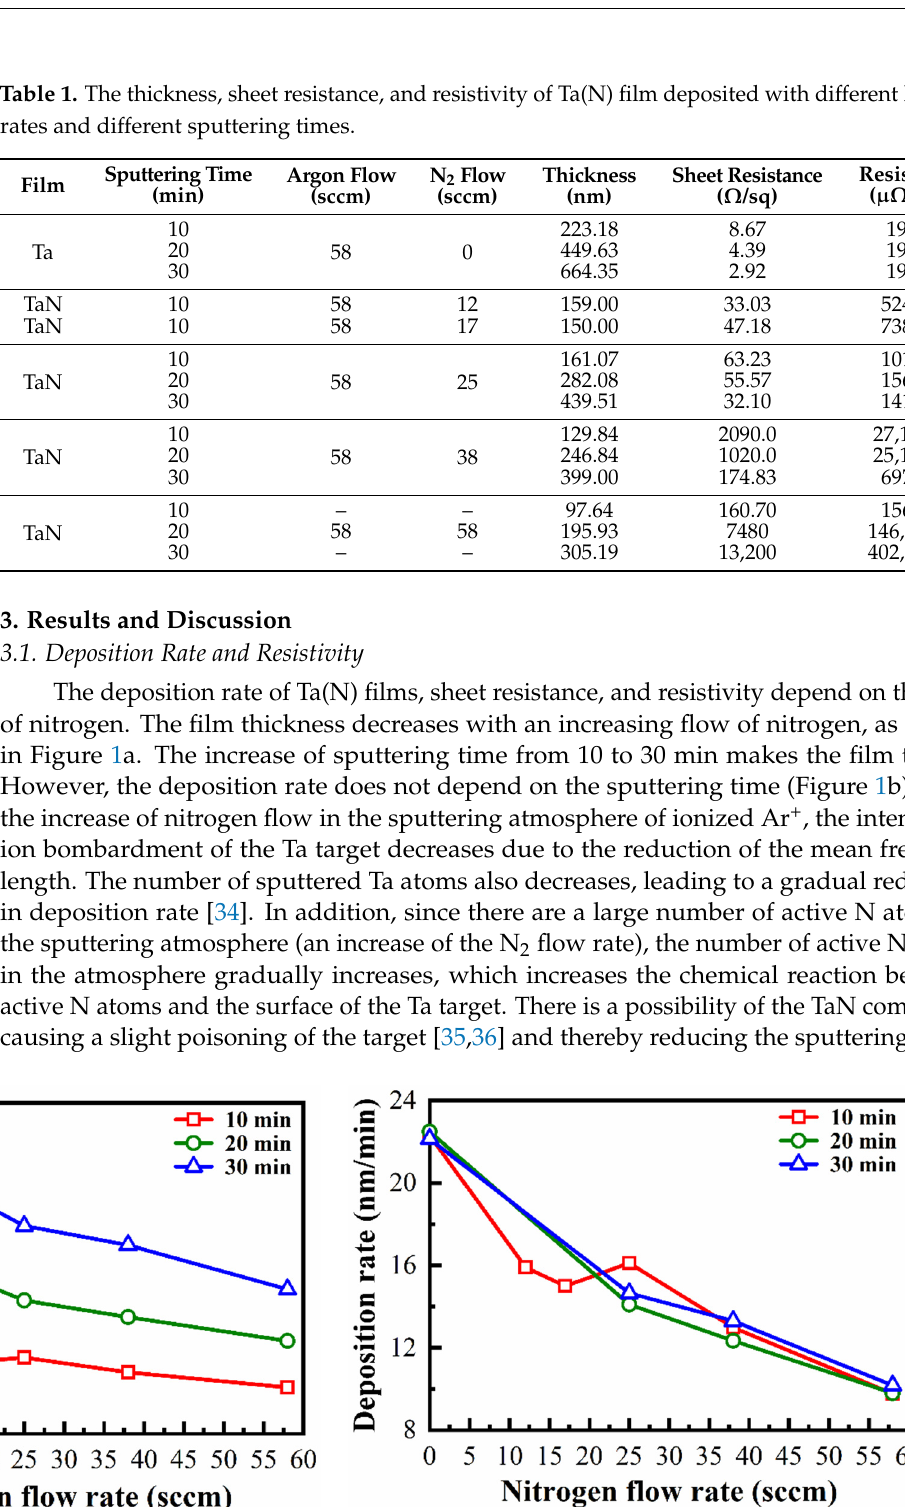
Table 1. The thickness, sheet resistance, and resistivity of Ta(N) film deposited with different N 2 flow rates and different sputtering times.